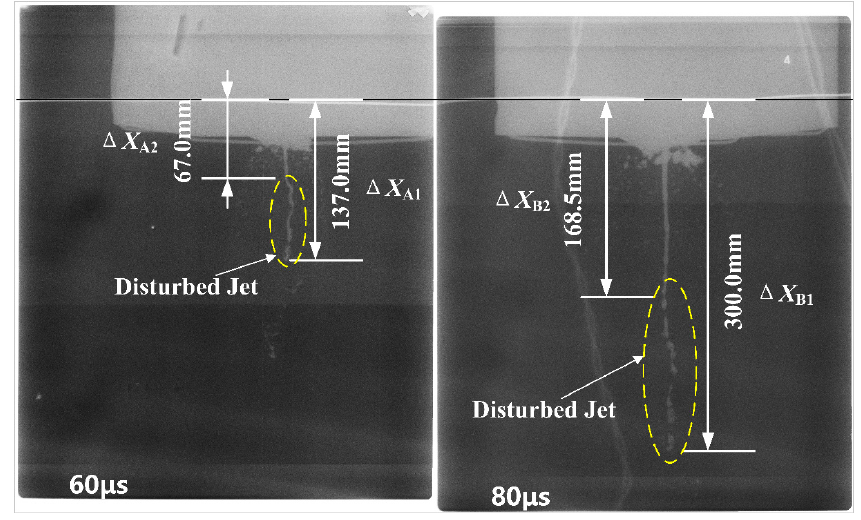
Figure 18. Site layout of the X-ray experiment. Table 5. X-ray test layout parameters.